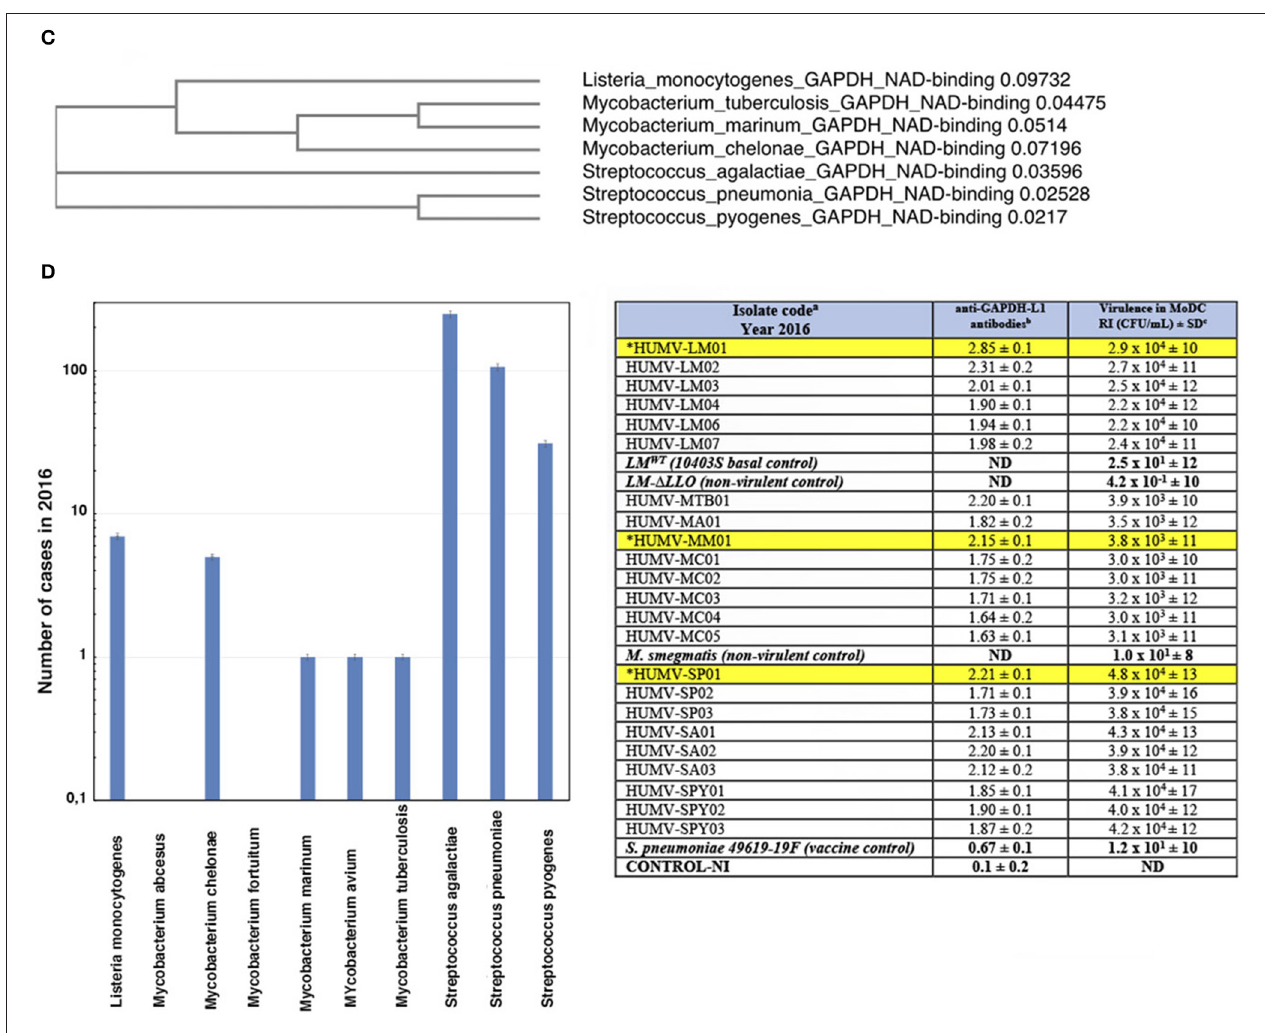
FIGURE 1 | Scheme of the study and selection of the bacterial antigens for the vaccine vectors. (A) Scheme explaining our strategy in this study. First DC are incubated with the different antigen forms: recombinant L. monocytogenes GAPDH proteins or mRNA-LIPO-GAPDH carriers for screening of the suitable ones, causing DC activation with minimal apoptosis induction. DC vaccines loaded with the different antigens are tested for DTH responses as a measurement of T cell responses. DC vaccines with the maximal DTH responses are tested for vaccination experiments followed by bacterial challenge. (B) Multiple alignment of GAPDH sequences of NAD-binding domains of the following bacteria detected at our Health Institution showing more than 95% homology: Listeria monocytogenes (A0A0B8RGN3_LISM), M. tuberculosis (A0A045ITJ4_MYCTX), M. chelonae (A0A0E3TR96_MYCCH) M. marinum (A0A2Z5YDP2_MYCMR), S. agalactiae (Q9ALW2_STRAG), S. pyogenes (G3P_STRPY), and S. pneumoniae (I6L8L9_STREE) protein sequences using CLUSTAL O (1.2.4) multiple sequence alignment. The aligned regions correspond to the InterPro domain IPR020828 that all the proteins have at the beginning of their sequence. The InterPro domain IPR020828 corresponds to the Glyceraldehyde 3-phosphate dehydrogenase, NAD(P) binding domain: https://www.ebi.ac.uk/interpro/entry/InterPro/IPR020828/. The consensus symbols are taken from https://www.ebi.ac.uk/seqdb/confluence/display/JDSAT/Clustal+Omega+FAQ#ClustalOmegaFAQ-Whatdotheconsensussymbolsmeanin thealignment? The symbols meaning is explained in Materials and Methods section Bioinformatics Analyses . Colors on protein alignments correspond to residues according to their physicochemical properties: RED corresponds to Small (small + hydrophobic-including aromatic-Y), BLUE corresponds to acidic, MAGENTA corresponds to basic—H, GREEN corresponds to hydroxyl + sulfhydryl + amine + G and GRAY corresponds to unusual amino/imino acids (see Supplementary Material for complete residues description). (C) Phylogenetic tree of the seven bacteria species compared in this study. The tree data are the following: (Listeria_monocytogenes_GAPDH_NAD-binding:0.09732, ((Mycobacterium_tuberculosis_GAPDH_NAD-binding:0.04475, Mycobacterium_marinum_GAPDH_NAD-binding:0.05140):0.03060, Mycobacterium_chelonae_GAPDH_NAD-binding:0.07196):0.31226):0.14525, Streptococcus_agalactiae_GAPDH_NAD-binding:0.03596, (Streptococcus_pneumonia_GAPDH_NAD-binding:0.02528, Streptococcus_pyogenes_GAPDH_NAD-binding:0.02170):0.01751); (D) Analyses of the clinical cases of bacteria species after the bioinformatic analysis of GAPDH sequences showing 95% homologies in B and detected in the year 2016 at the Hospital U. Marqués de Valdecilla (Microbiology Dpt) from a complete study from 2014 to 2019 (graphic on the left). In the Table (on the right), we show sera from patients (HUMV codes) infected with the bacterial strains of B and examined for anti-LM-GAPDH 1 − 22 antibodies using a peptide ELISA. Sera were collected from patients and storage at − 80 ◦ C. In the table, we present the antibody titers of patients from a representative 2016 year and with anti-GAPDH-L1 titers higher than 2.0 OD after performing a peptide-specific ELISA. Results are presented